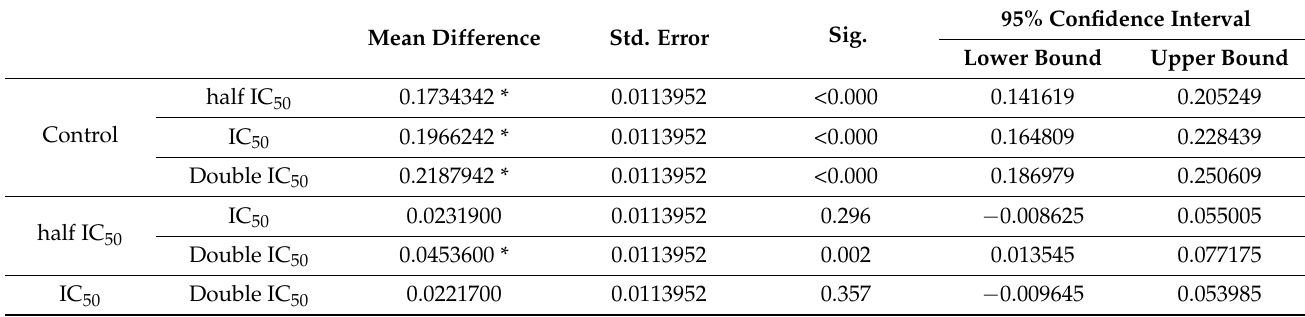
Table 10. Post hoc comparison test (Bonferroni) of NAF values of different concentrations of P-Lip-treated cells and control cells. Mean Difference Std. Error Sig.